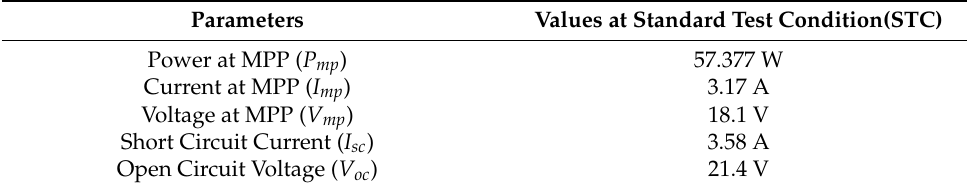
Table 2. Rating of user-defined PV module at STC, T = 25 ◦ C, and irradiance = 1000 W/m 2 .